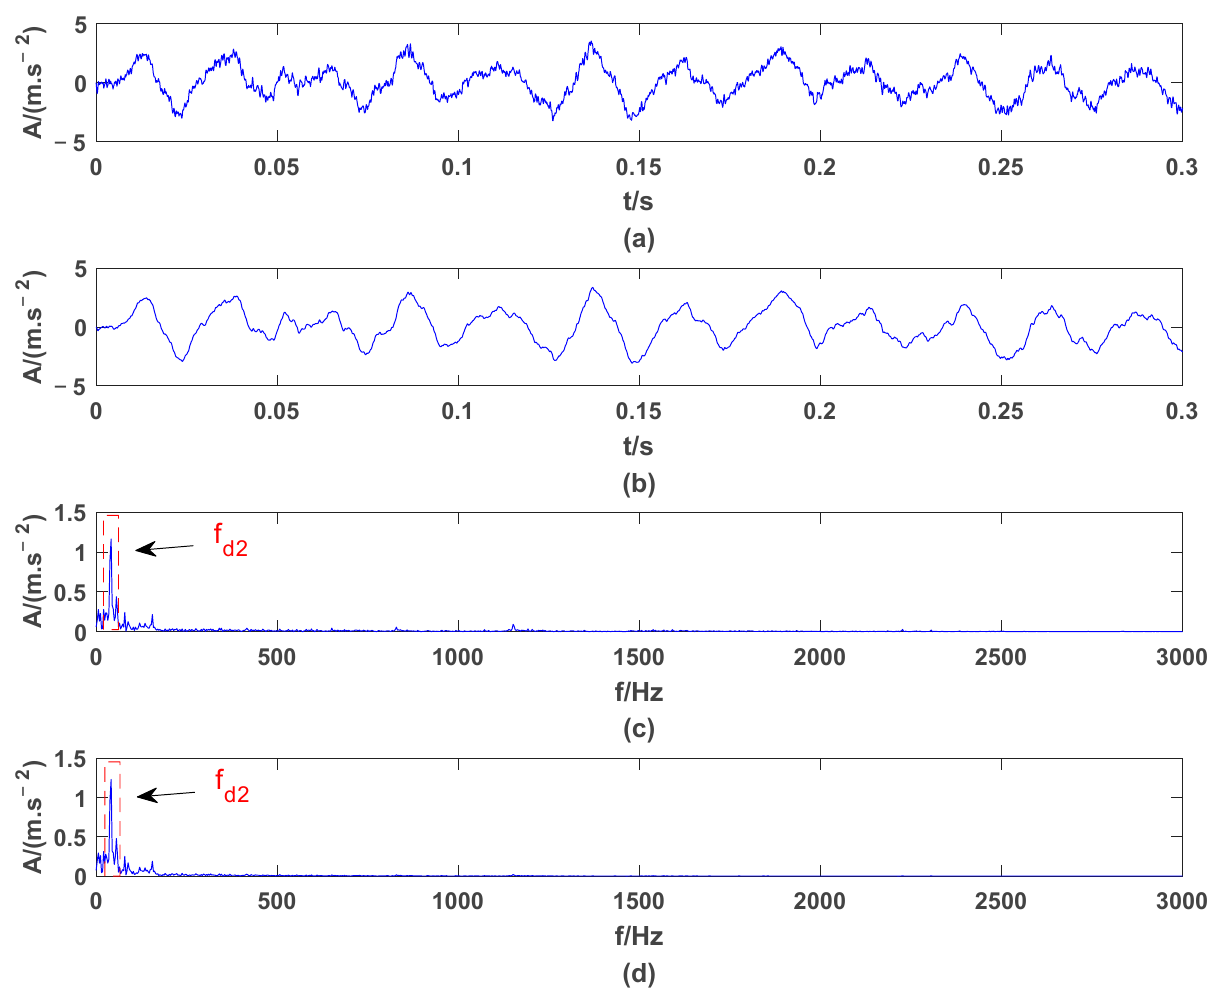
Figure 10. The output signal of ER-16K ( a ) time domain curve of the PTSR system ( b ) time domain curve of PTSR method in the underdamped state ( c ) frequency domain curve of PTSR method ( d ) frequency domain curve of PTSR method in the underdamped state.